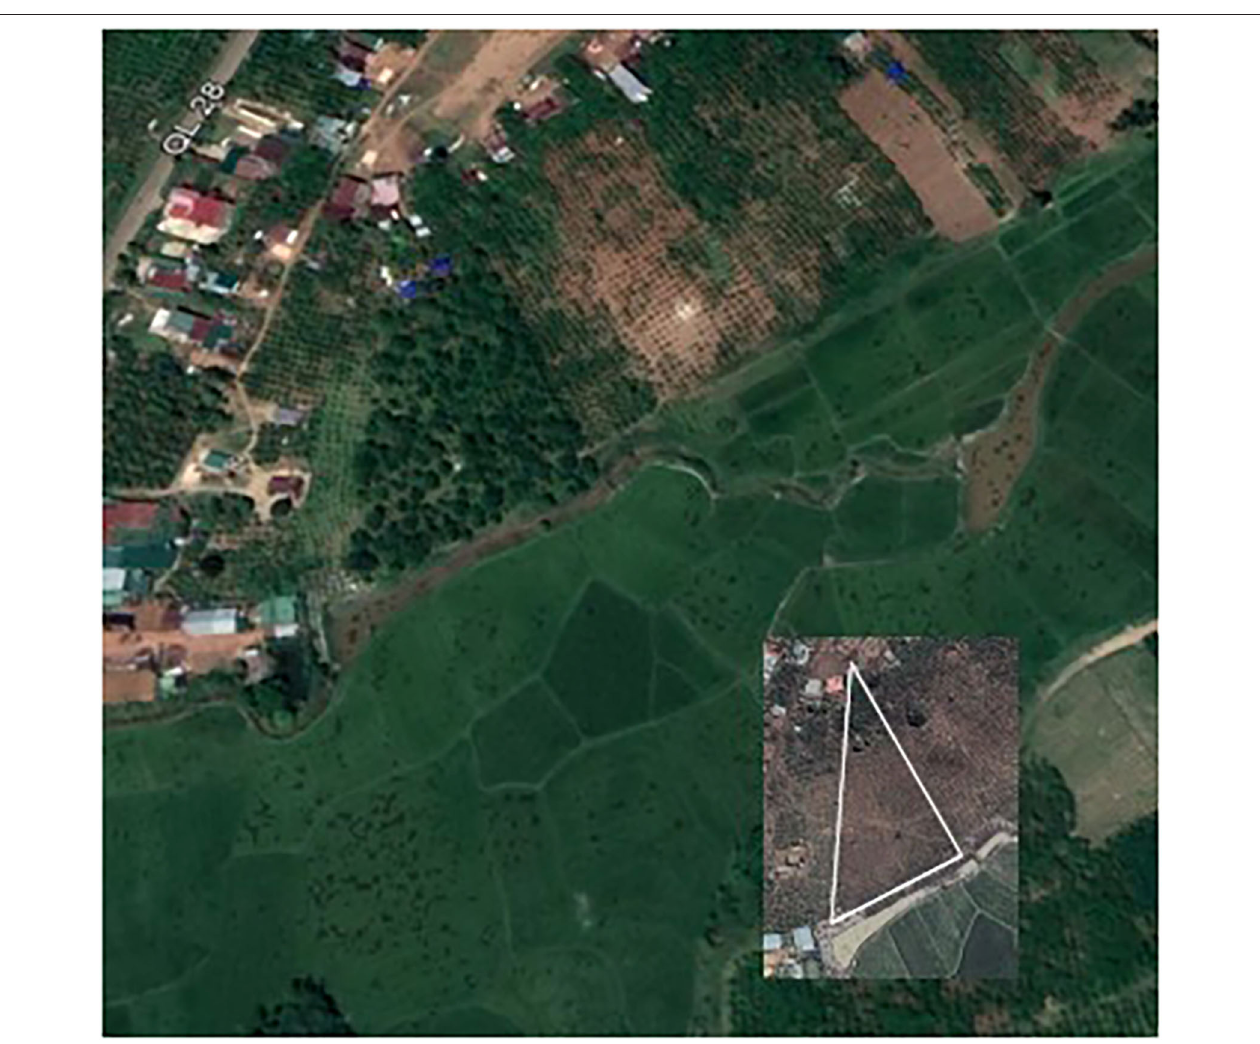
FIGURE 2 | Triangular shape shade-grown coffee farm (regenerative) in 2019 vs. 2013. Source: Google Earth, Image @2013 and @2019